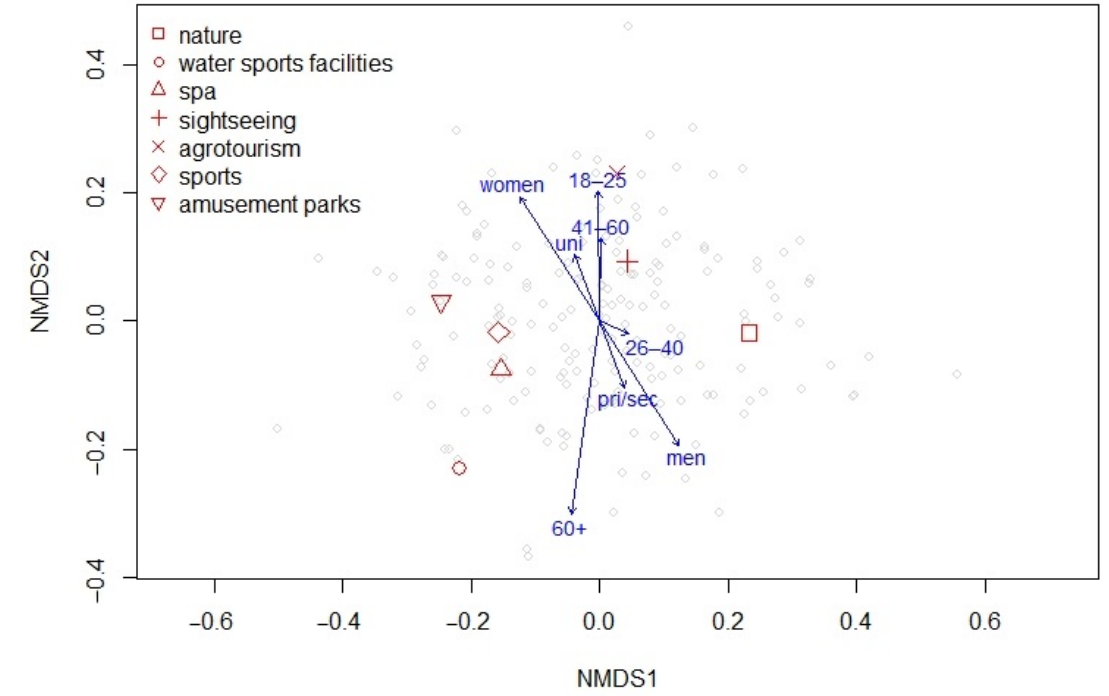
Figure 7. Multidimensional scaling of preference landscape for recreation by respondents (uni—university education; pri/sec—primary and secondary education).